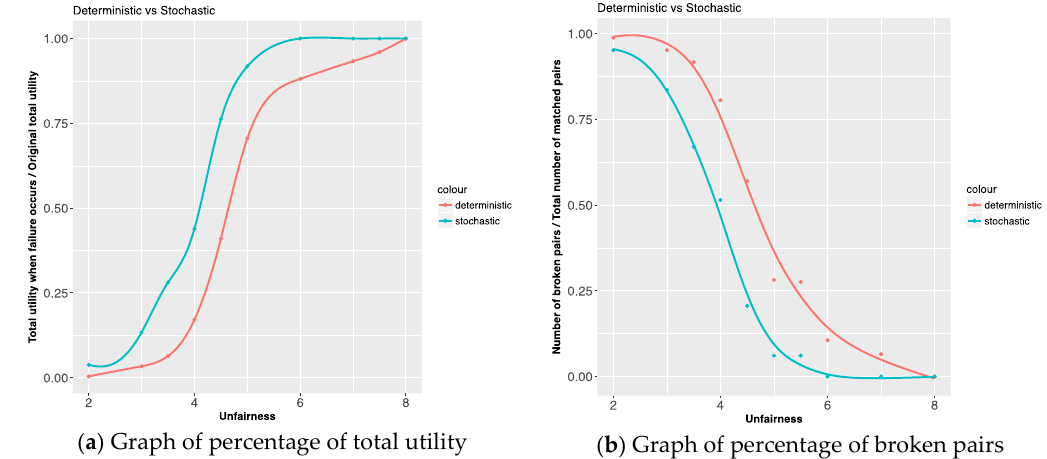
Figure 6. Figure 7b has an x-axis of unfairness and a y-axis of the number of broken pairs divided by Figure 7a. The stochastic model is more effective than the deterministic model in that it selects and maintains pairs with an appropriate range of the unfairness indicator.